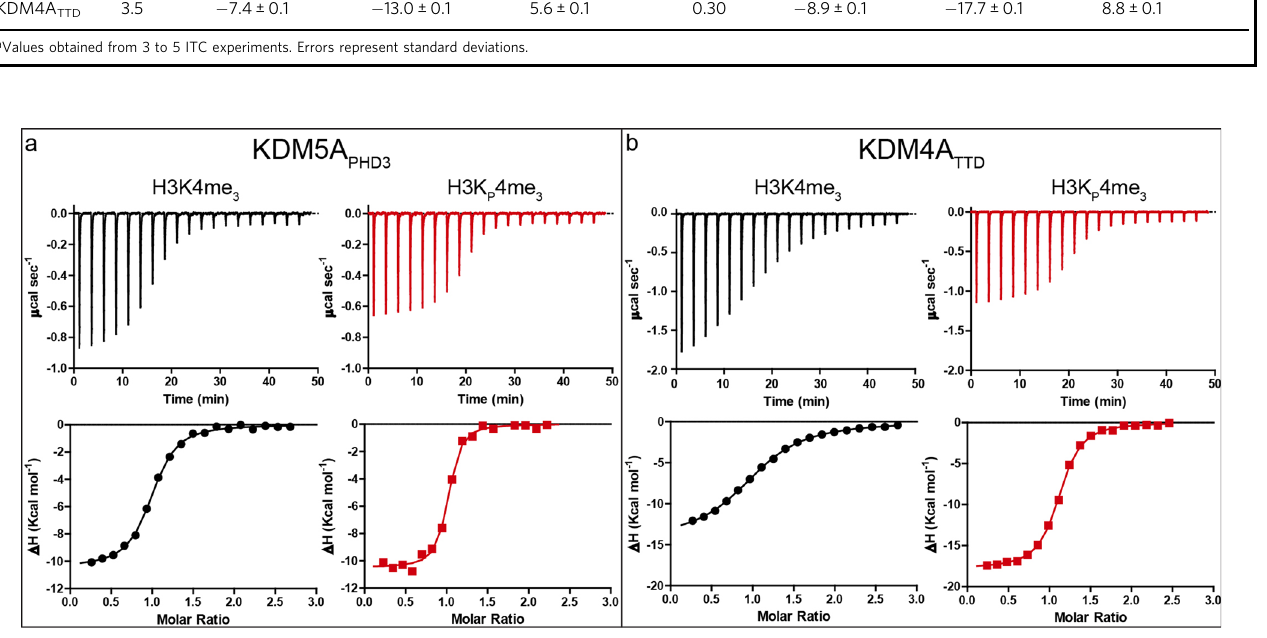
Fig. 2 Thermodynamic analyses of binding. Representative ITC results from the interaction of ( a ) KDM5A PHD3 and ( b ) KDM4A TTD with H3K4me 3 (black) or H3K P 4me 3 (red) substrates. Top panels show the raw ITC data and the bottom panels show the processed